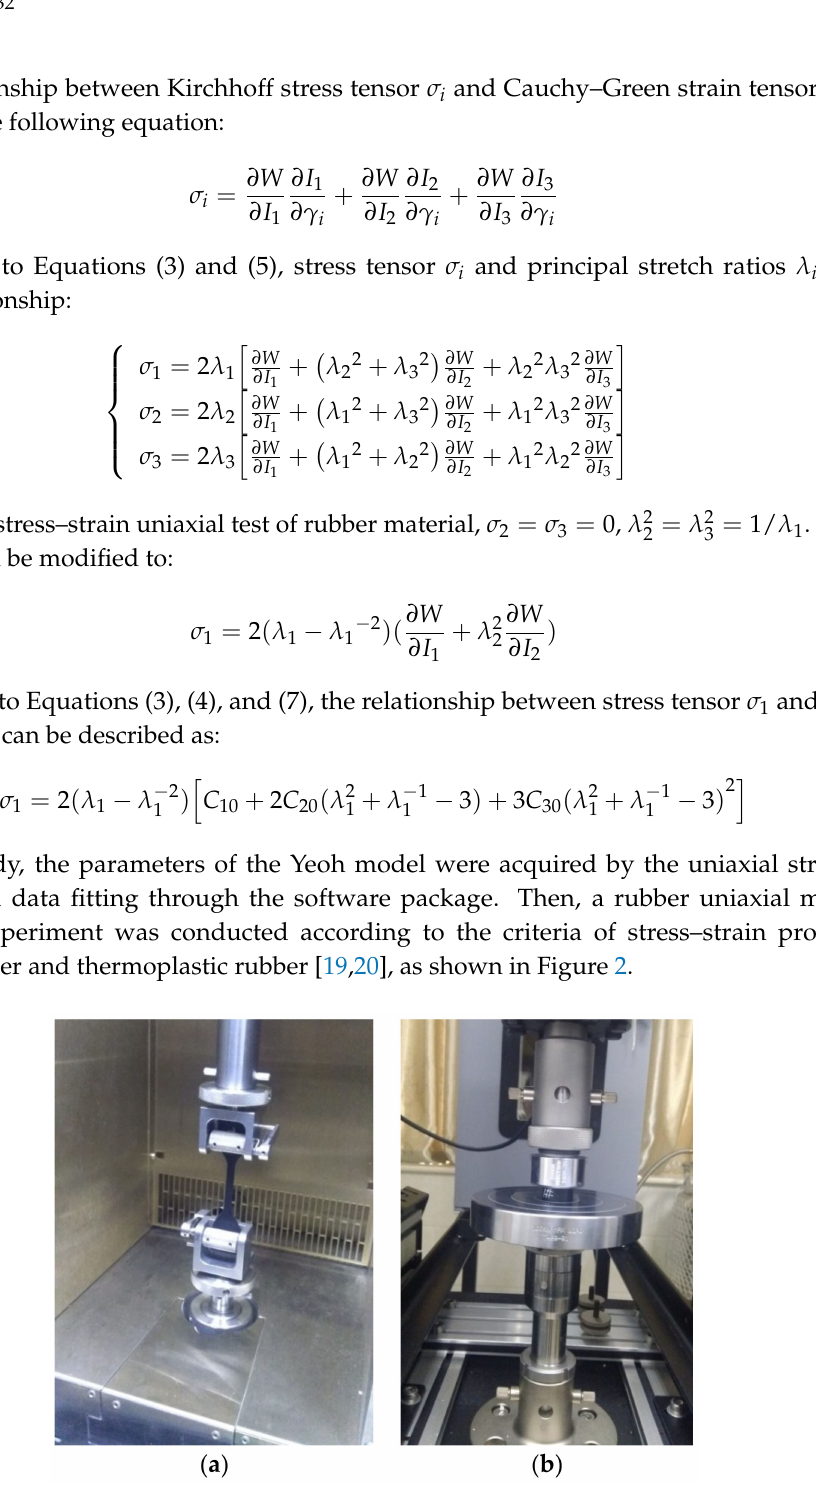
Figure 2. The mechanics performance test of rubber: ( a ) uniaxial tensile test; ( b ) uniaxial compression test. By fitting the data acquired in the uniaxial tests, the parameters of the constitutive model were obtained, which were C 10 = 1.4109, C 20 = 1.3113 × 10 − 2 , and C 30 = − 1.492 × 10 − 4 ,